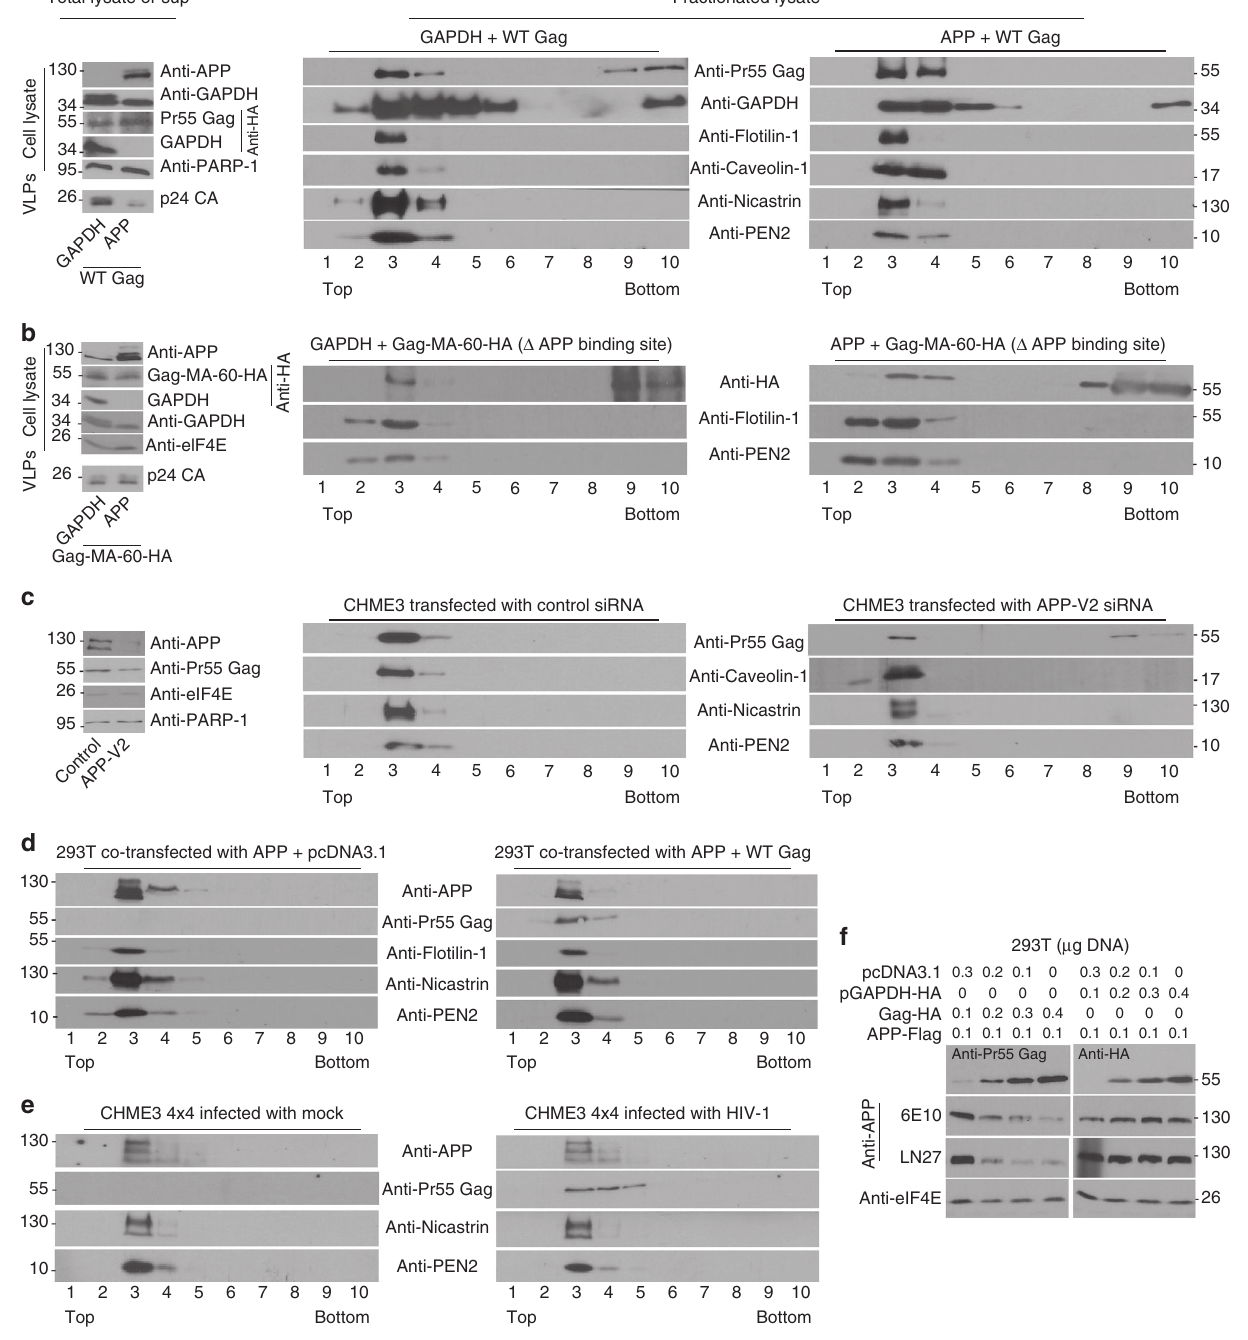
Fig. 4 APP causes Gag retention in membrane domains. a , b Analysis of cell lysates or supernatant VLPs (left panels) or fractionated lysates from fl otation assays (right panels). a Left: In cells expressing WT Gag, APP expression reduces VLP levels in cell supernatants. Right: HIV-1 Gag is present in both membrane-free (8 – 10) and membrane-bound fractions containing lipid raft and γ -secretase components (2 – 4) in control samples, but is solely membrane- bound in APP-expressing 293T cells. b Left: In cells expressing mutant Gag that does not bind APP, APP expression does not affect VLP levels in cell supernatants. Right: HIV-1 Gag lacking the APP-binding site is present in membrane-free fractions in both control and APP-expressing 293T cells. c Left: WB veri fi cation of APP depletion in cell lysates. Right: RNAi-mediated depletion of APP increases the release of HIV-1 Gag into membrane-free fractions in CHME3 cells transfected with HIV-1 Gag expression plasmid. d , e HIV-1 Gag expression does not release APP from membrane-bound fractions containing lipid raft and γ -secretase components in transfected 293T cells ( d ) or in CHME3 4 × 4 cells infected with WT HIV-1 ( e ). f Increasing Gag-HA expression results in decreased APP levels in transfected 293T cells compared with control GAPDH-HA expression. Molecular weight markers (in kDa) are shown either to the right or to the left of WBs